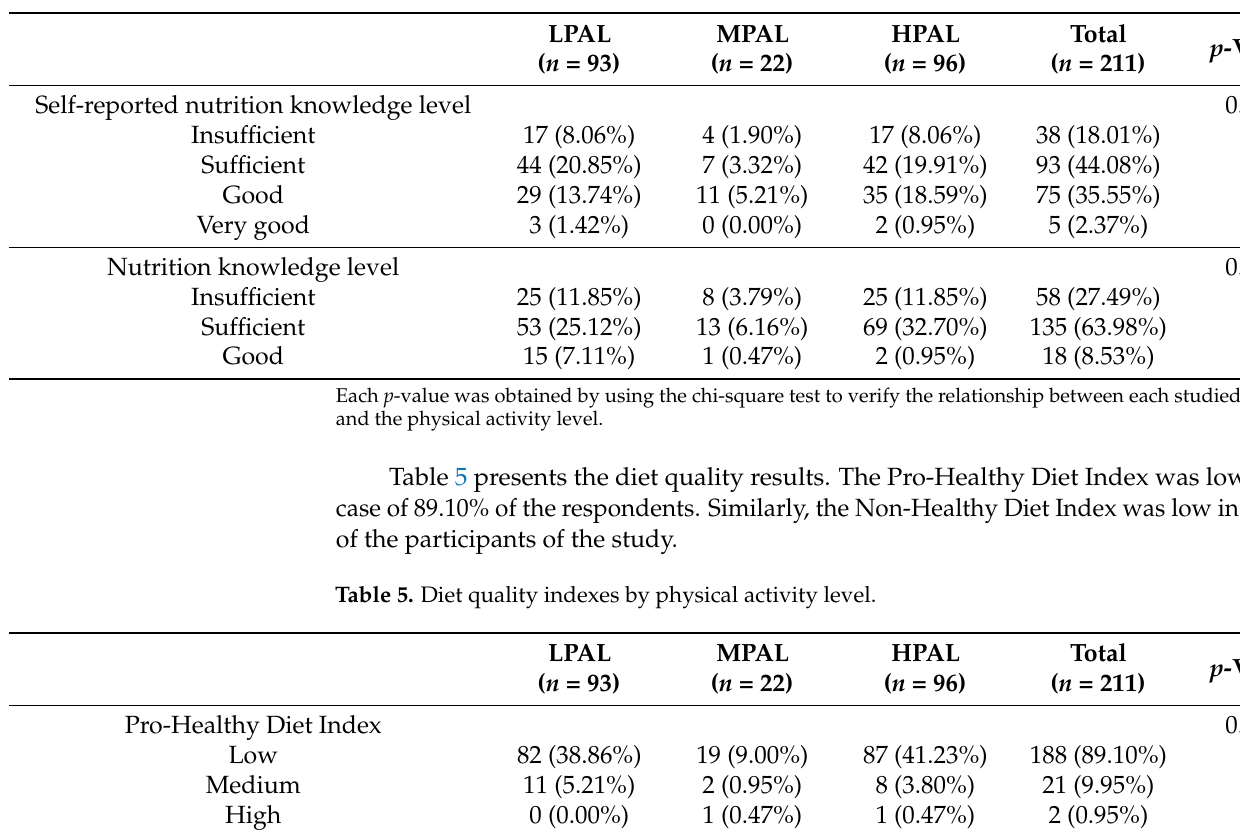
Table 4. Nutrition knowledge of prisoners by physical activity